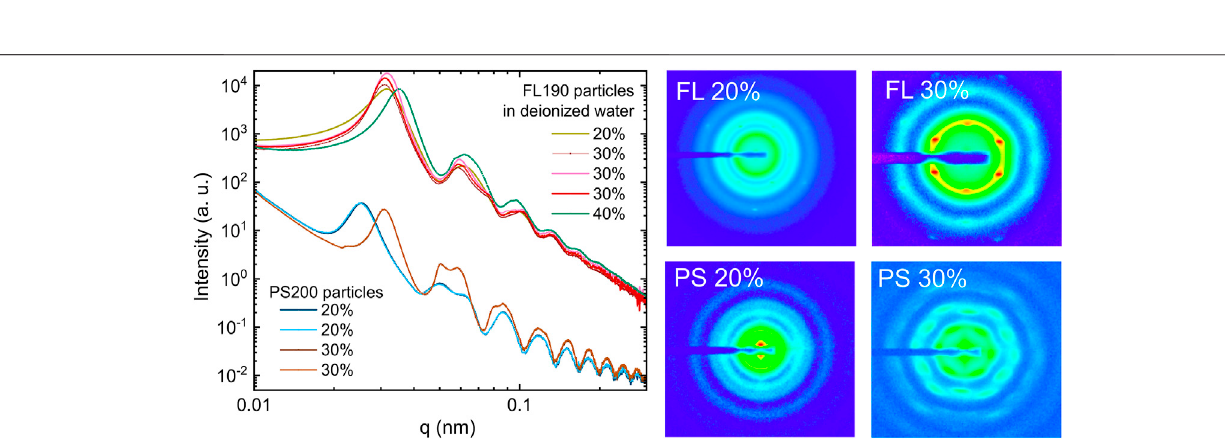
Frontiers in Physics |